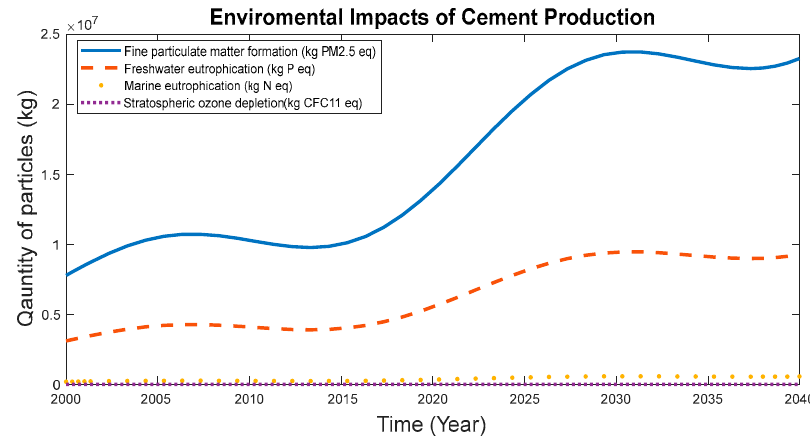
Figure 7. Plot showing a possible long-term environmental impact of cement production in South